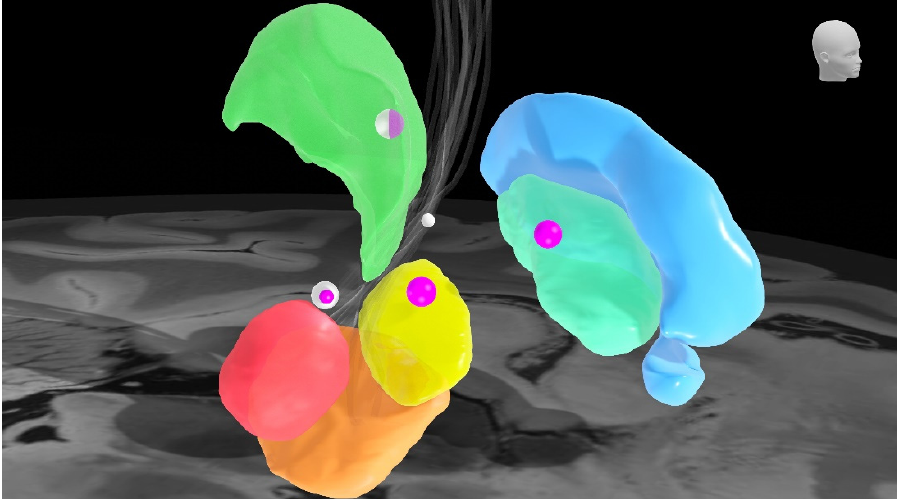
Figure 1. Deep brain stimulation targets and corresponding levels of evidence. The sphere size corresponds to the level of evidence for that specific target; higher evidence levels correspond to larger spheres. White spheres: essential tremor. Purple spheres: Parkinson’s disease. Brain nuclei: green: ventral motor part of the thalamus, sky blue: external pallidum, turquoise: internal pallidum, yellow: subthalamic nucleus, orange: substantia nigra, red: red nucleus. Grey fibers: dentato-rubro-thalamic tract.